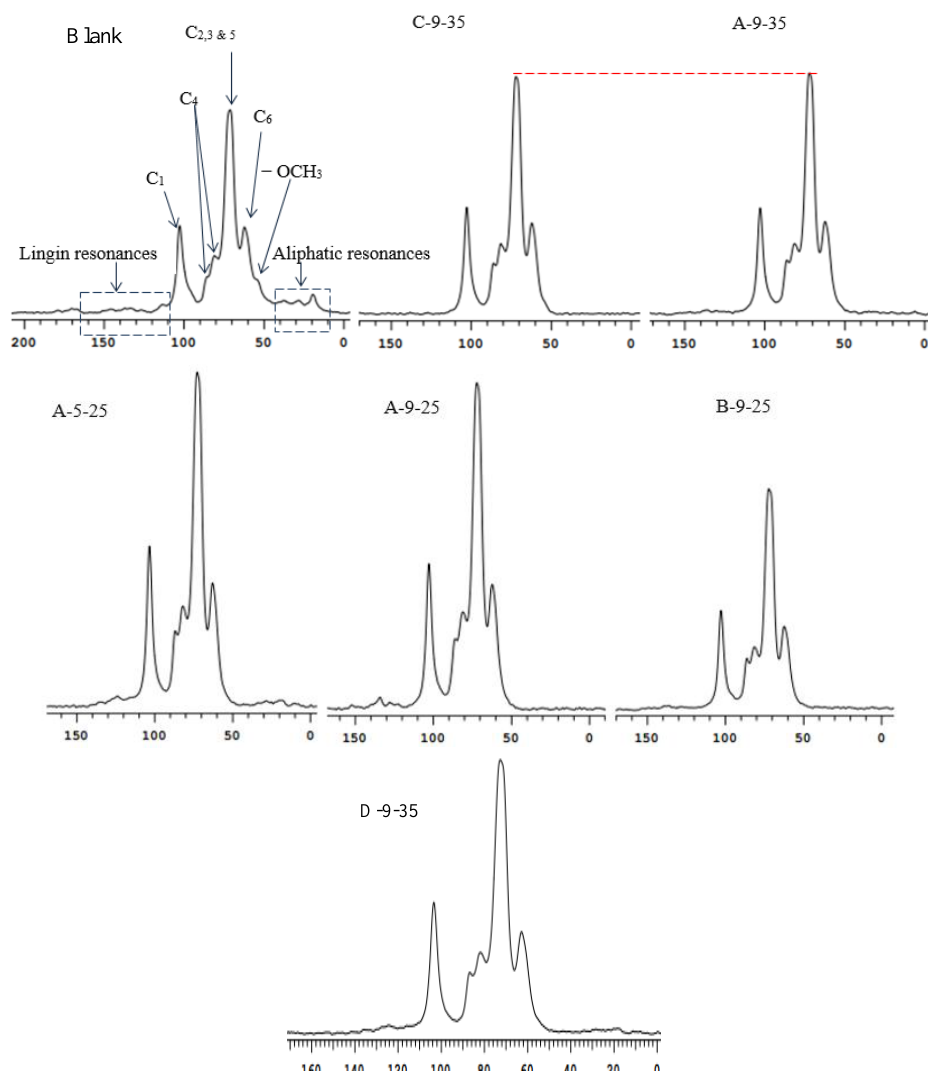
Figure 5. Cross-Polarization Magic Angle Spinning Carbon-13 Nuclear Magnetic Resonance (CP/MAS 13 C-NMR) spectra of the samples before/after combined pretreatment. A-5-25: 2% NaOH at 80 °C for 2 h and the ozone initial pH 5 for 25 min. A-9-25: 2% NaOH at 80 °C for 2 h and the ozone initial pH 9 for 25 min. A-9-35: 2% NaOH at 80 °C for 2 h and the ozone initial pH 9 for 35 min. B-9-25: 2% NaOH at 80 °C for 3 h and the ozone initial pH 9 for 25 min. C-9-35: 2% NaOH at 60 °C for 2 h and the ozone initial pH 9 for 35 min. D-9-35: 2% NaOH at 80 °C for 4 h and the ozone initial pH 9 for 35 min. Blank: untreated degreased stover.